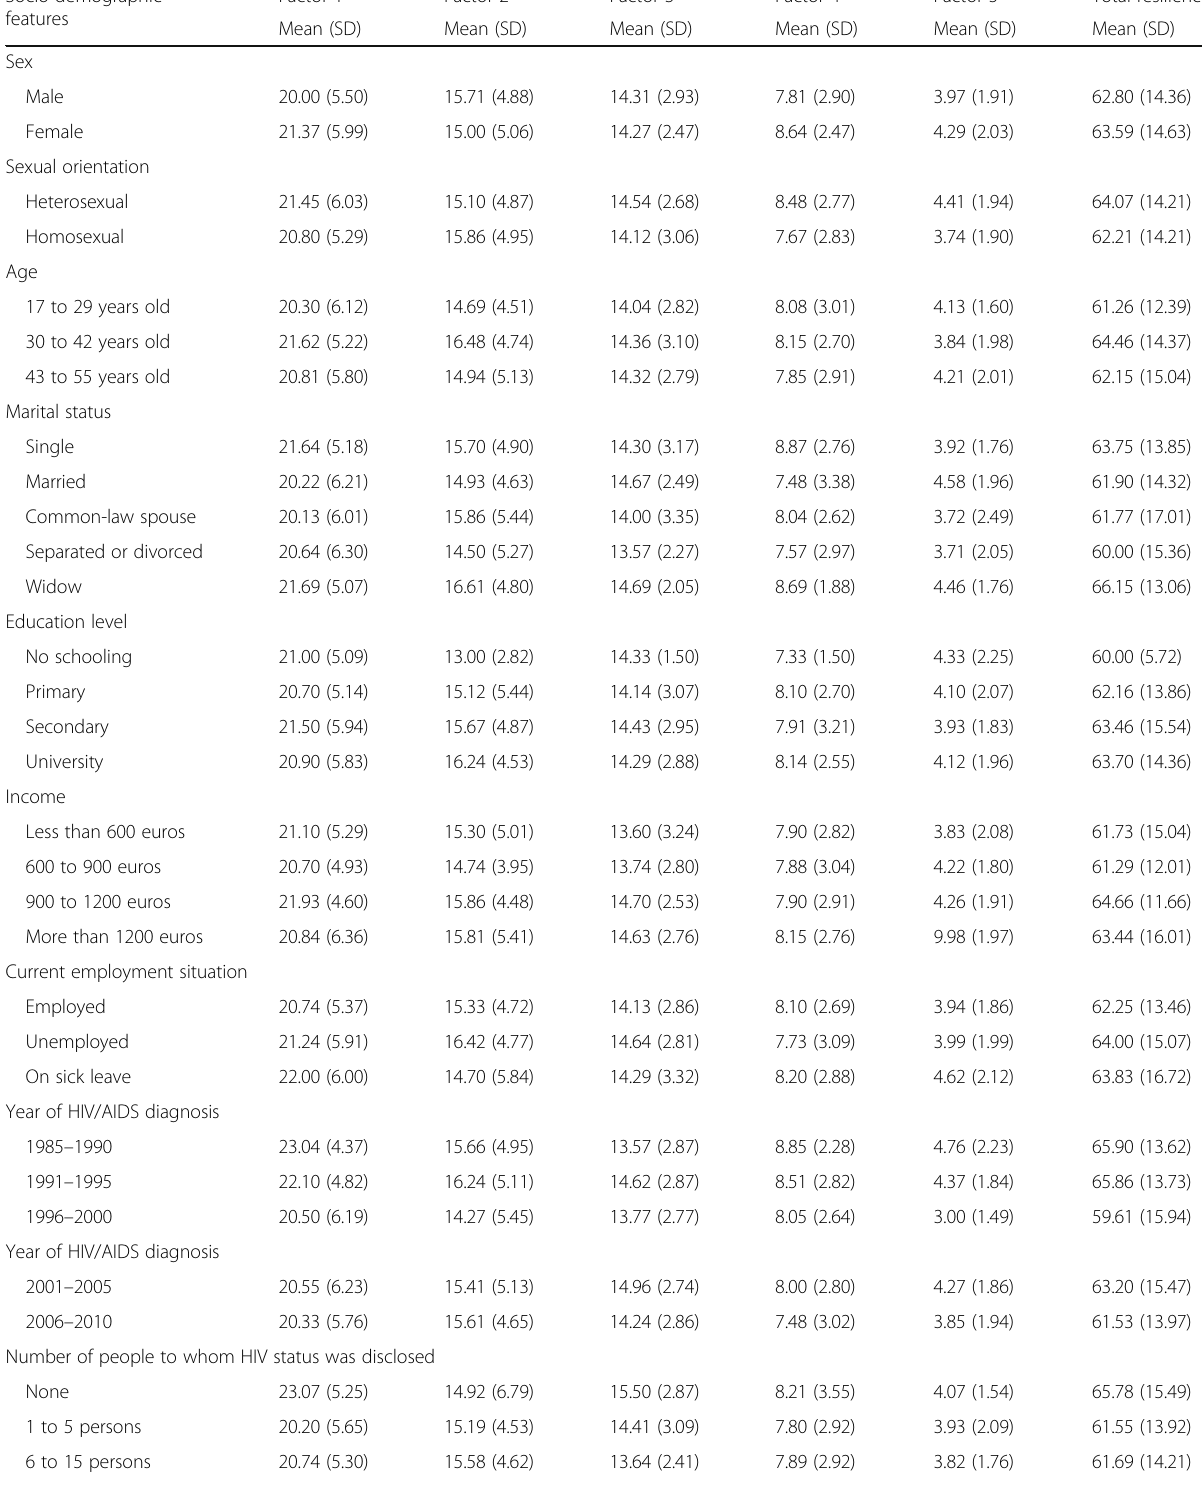
Table 2 Means and standard deviations in resilience factors according to socio-demographic variables Socio-demographic